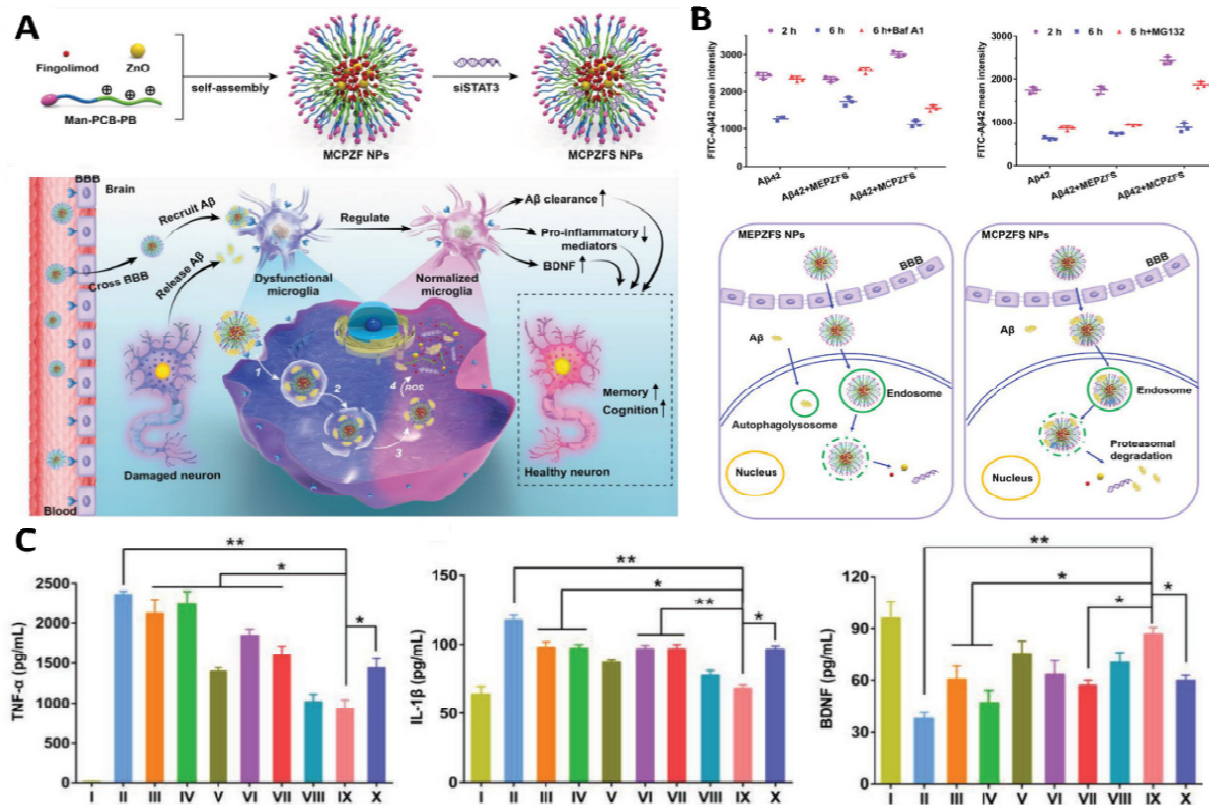
Figure 4. Immune-modulating effect of a PCB-based zwitterionic nanoparticle for AD therapy. ( A ) MCPZFS NPs for AD therapy: structure, preparation, and mechanism. MCPZFS NPs can penetrate the BBB and endocytose into microglia cells to normalized malfunctioning microglia. Pro-inflammatory mediators were reduced. Microglia’s phagocytic capacity was restored when BDNF production rose. The injured neuron is then healed in numerous ways. (1) NPs endocytosed amyloid- β into microglia. (2) After perturbing the endosome/lysosome membrane, NPs leaked into the cytoplasm. (4) Finally, ROS-mediated release of fingolimod, siSTAT3, ZnO, and amyloid- β . ( B ) The effect of NPs on microglial phagocytosis and A β degradation after 2 h co-incubation with